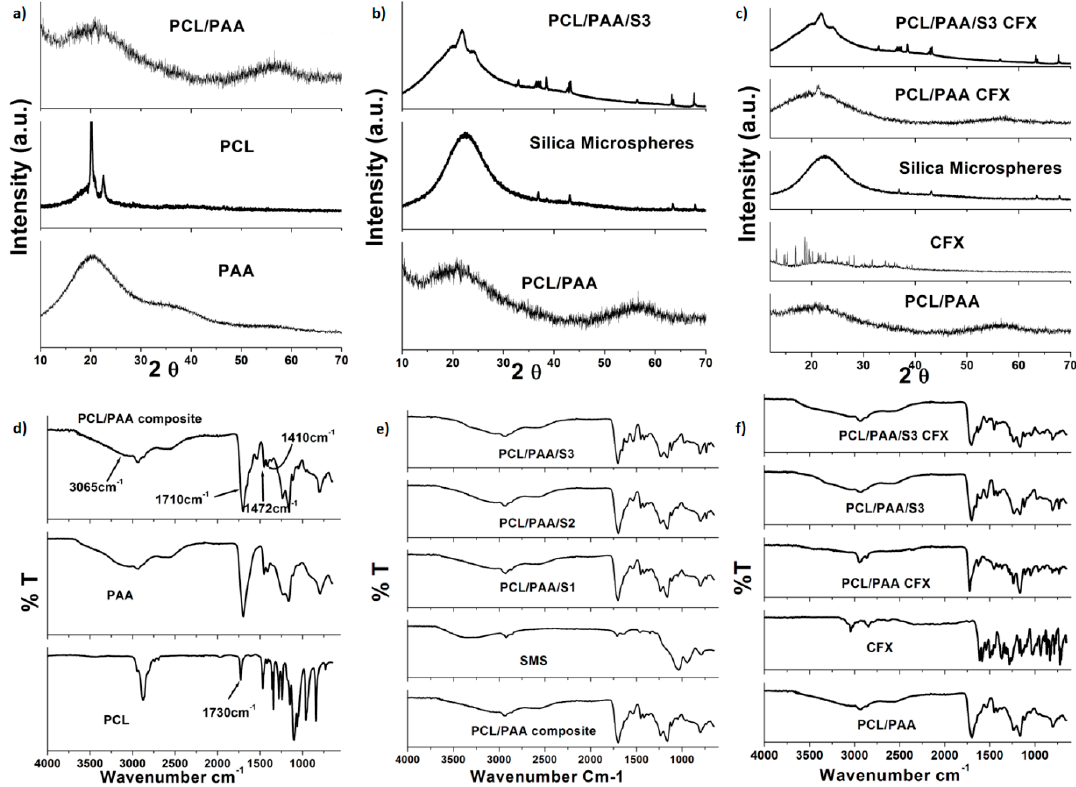
Figure 3. X-ray diffraction (XRD) patterns of ( a ) blending of PCL with PAA; ( b ) incorporation of silica microspheres into PCL/PAA blends; ( c ) encapsulation of CFX into the PCL/PAA blends and Fourier Transform Infrared (FTIR) spectra of; ( d ) blending of PCL with PAA; ( e ) incorporation of silica microspheres into PCL/PAA blends; ( f ) encapsulation of CFX into the PCL/PAA blends.